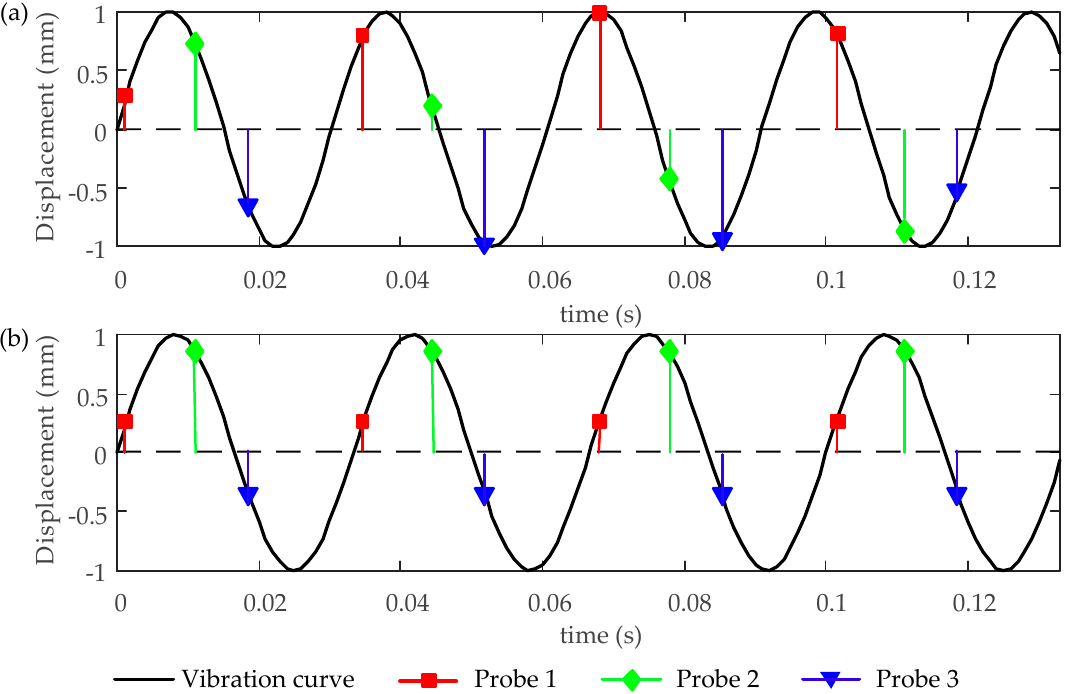
Figure 1. ( a ) Under-sampling of asynchronous vibration and ( b ) under-sampling of synchronous vibration.